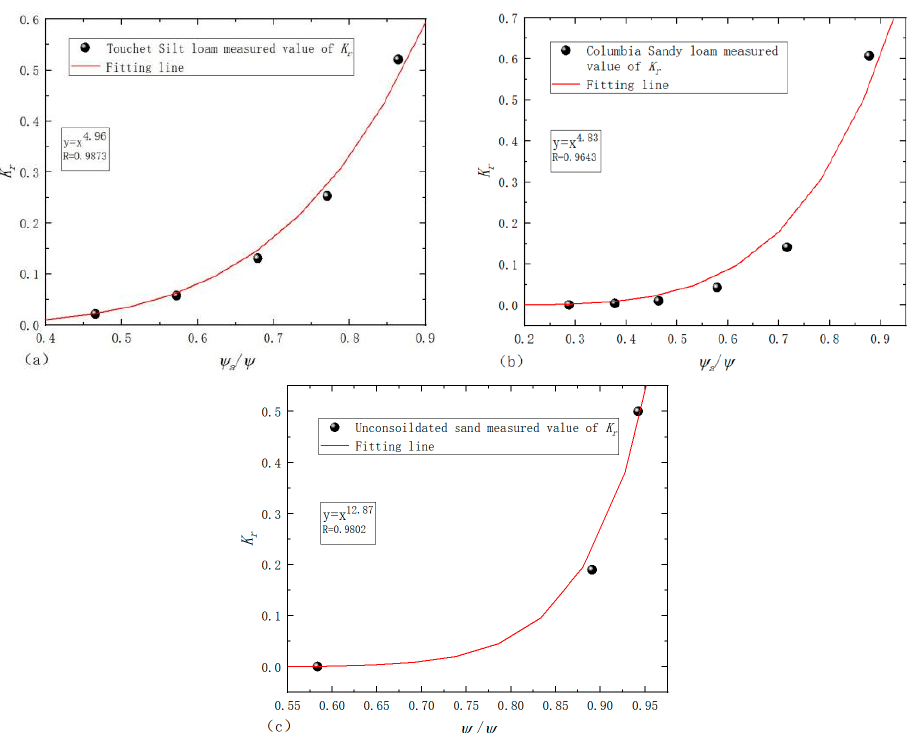
Figure 3. Fitting values of λ for three types of soil: ( a ) Touchet silt loam; ( b ) Columbia sandy loam; ( c ) unconsoildated sand.